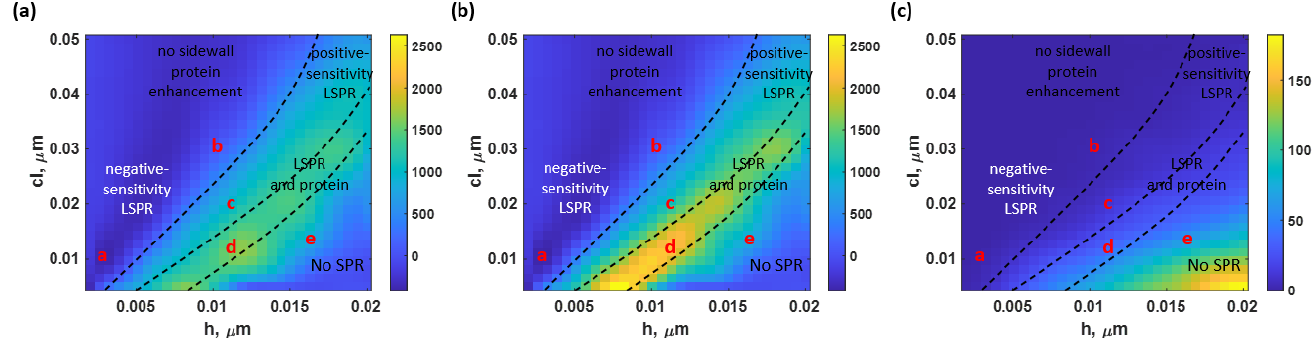
Figure 8. S of the ( a ) nonsidewall BSA model, ( b ) sidewall BSA model at different roughness levels in rad/µm 2 , and ( c ) the increase of the protein density due to sidewalls in percent as the surface roughness increased.